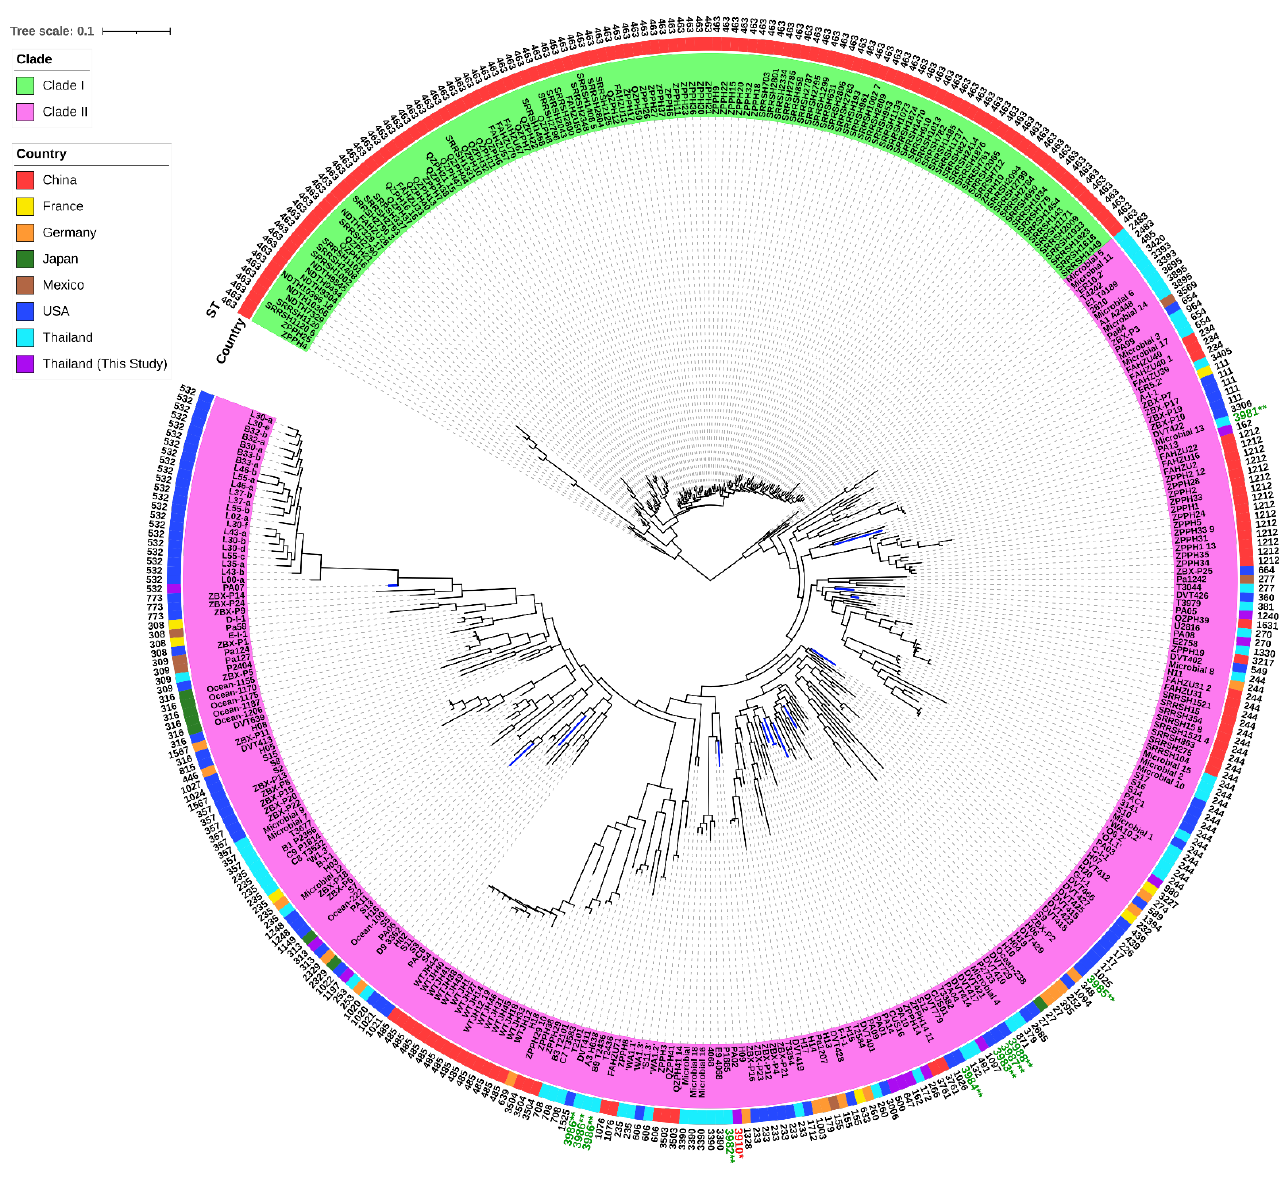
Figure 7. A single nucleotide polymorphism (SNP) phylogenetic tree of our genomes (blue linage) and other available genomes of P. aeruginosa . ST, sequence type. * Novel ST from our P. aeruginosa genome (red text). ** Novel STs from previously published genomes of P. aeruginosa (green text).